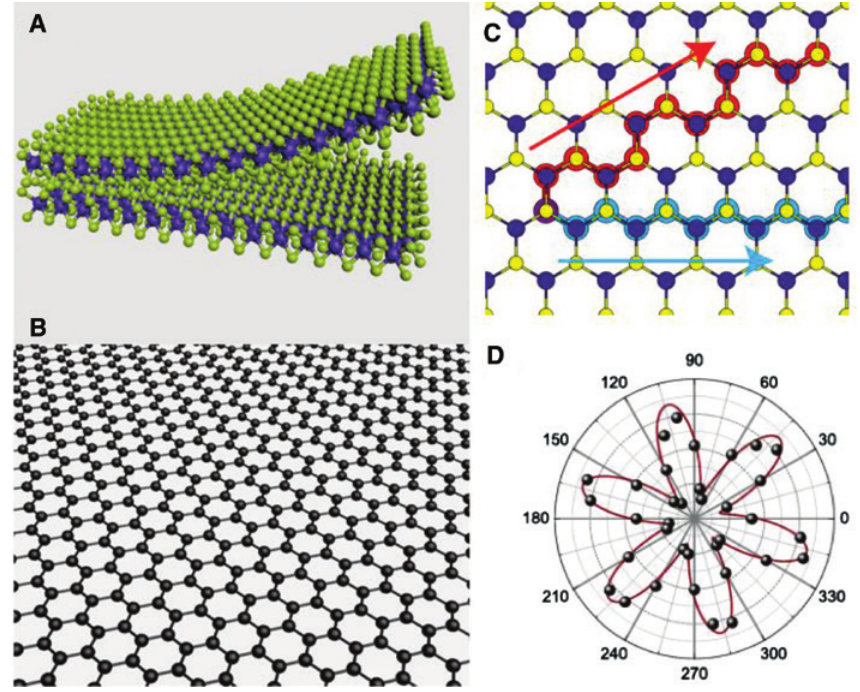
Figure 1: Atomic structure of layered 2D materials. Crystal structures and SHG spectroscopy of common layered materials. Schematic of (A) layered transition metal dichalcogenide (TMDC) material and (B) graphene. (C) The hexagonal crystal structure of TMDCs. The two directions shown are the zig-zag (show in blue) and arm-chair (shown in red) directions. (D) Due to the six-fold symmetry in the crystal structure, a six-fold pattern is observed in polarization resolved second harmonic generation experiment. Thus, based on the second harmonic signal, crystal axes can be mapped out. Figure 1D is reprinted from Ref.